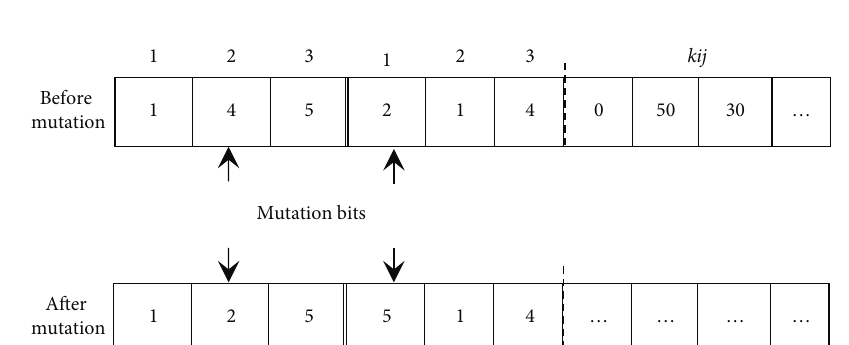
Figure 2: Example of a particle.